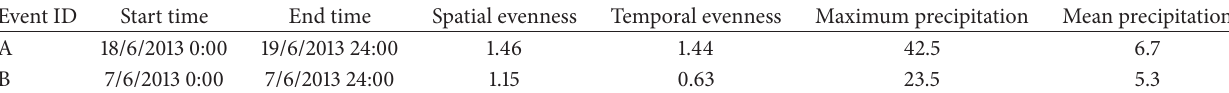
Table 2: Durations, maximum/mean rainfall accumulation, and spatial/temporal evenness of the heavy rain events.